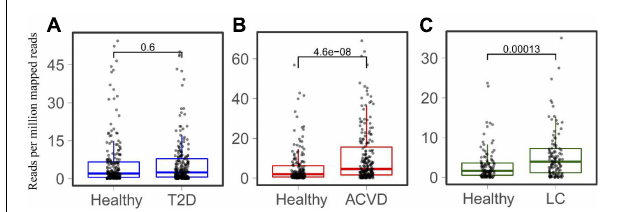
FIGURE 3 | Comparison of the total abundance of HepIs in the human gut microbiome between a healthy group and a disease group. The metagenomic datasets are from the disease conditions; Type 2 diabetes T2D (A) , cardiovascular disease CVD (B) , and liver cirrhosis LC (C) . The paired Wilcoxon test was used to calculate the p- value for significant